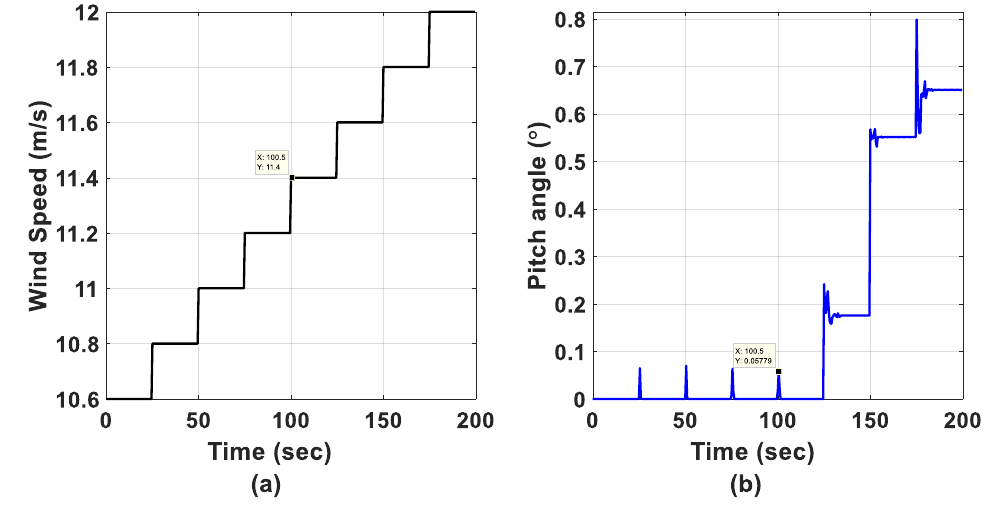
Figure 7. ( a ) Stepwise wind speed; ( b ) Pitch angle.